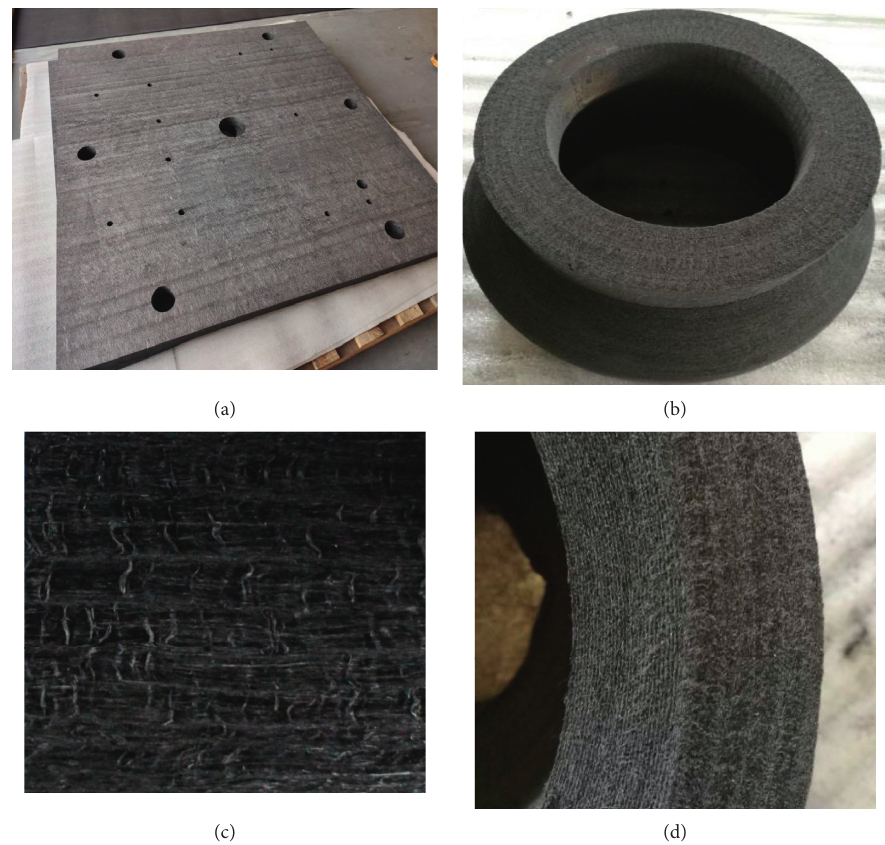
Figure 4: Carbon/carbon fiber composites: (a) plate material, (b) shaped material, (c) layer structure of the plate material, and (d) layer structure of the shaped material.